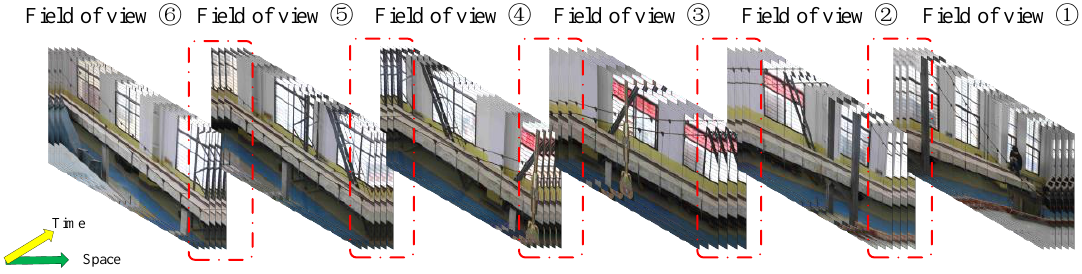
Figure 15. The spatiotemporal features of static image sequences .